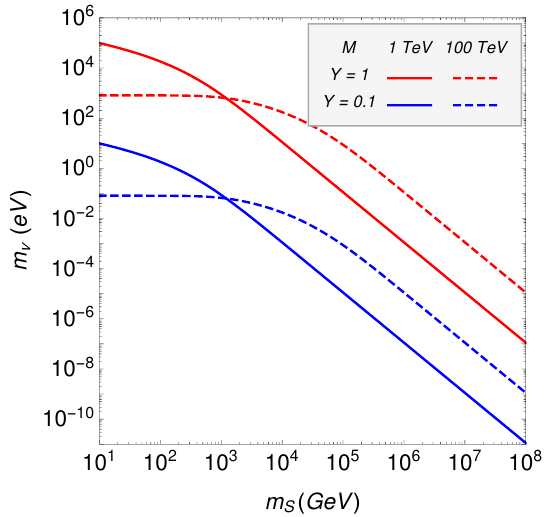
Figure 11 . The neutrino mass scale in model 1 for a few sample choices of parameters, see text for